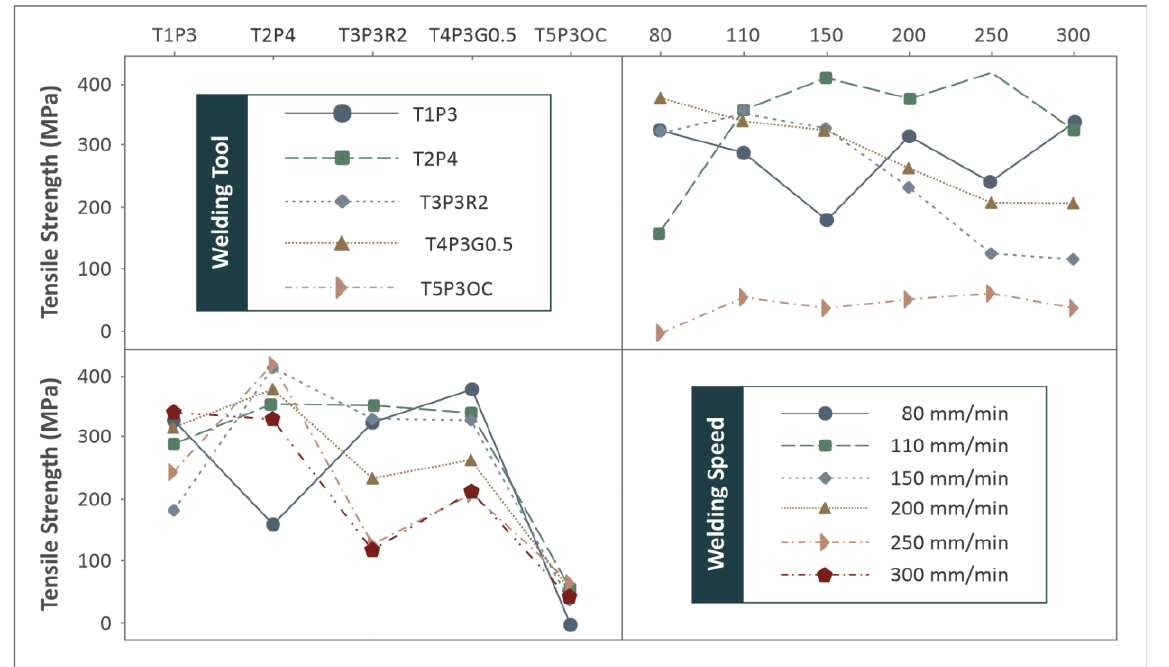
Figure 8. Interaction plots for the two FSW parameters studied, i.e., welding speed and welding tool.